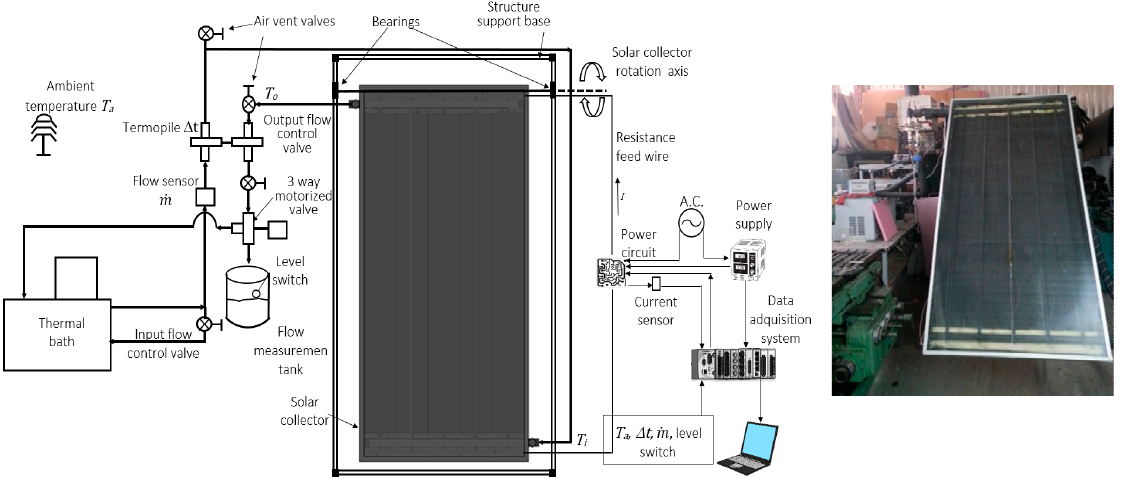
Figure 2. Experimental Setup.